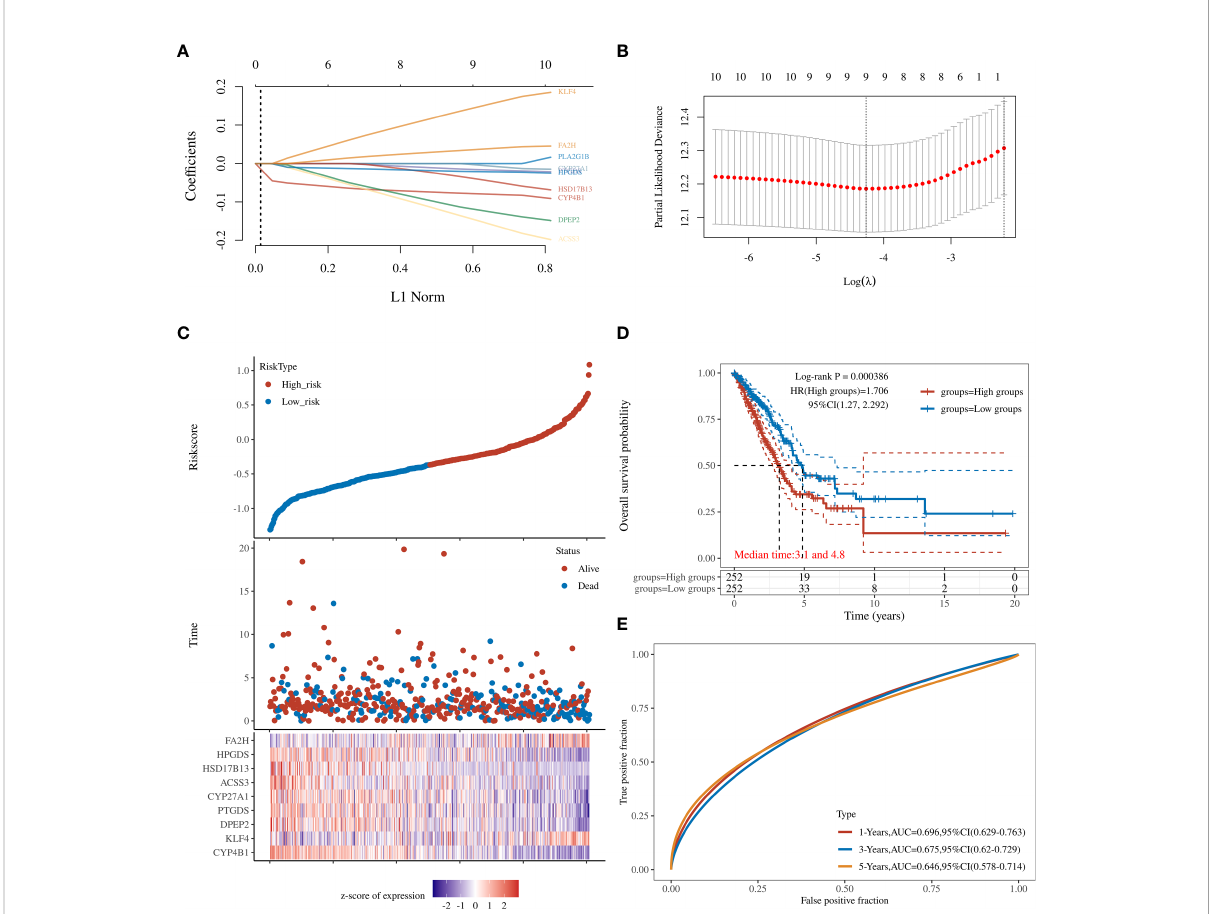
FIGURE 2 (A) LASSO regression analyses of the 12 OS-related genes. (B) Cross-validation for tuning the parameter selection in the LASSO regression. (C) The survival status for each patient (low-risk population: on the left side of the dotted line; high-risk population: on the right side of the dotted line). (D) Kaplan-Meier analysis for the OS of patients in the high- and low-risk groups. (E) The AUC of the prediction of 1-, 2-, and 3- year survival rates of